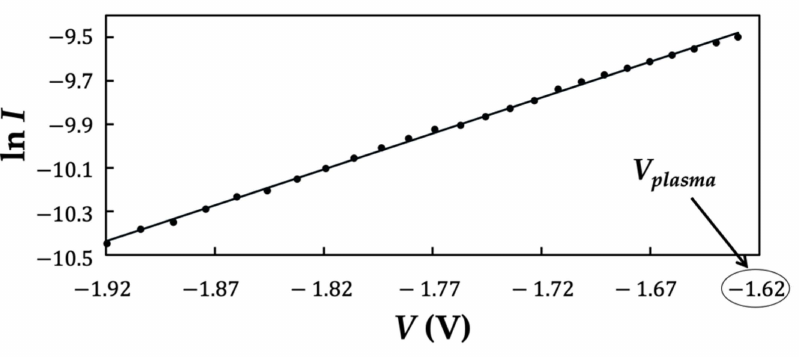
Figure 7. Curve ln I versus V in zone II of an experimental IVCP for the same discharge conditions as those in Figure 4. The linear zone contains 25 points and fits very well with a linear behavior since the correlation coefficient of the linear regression is r =